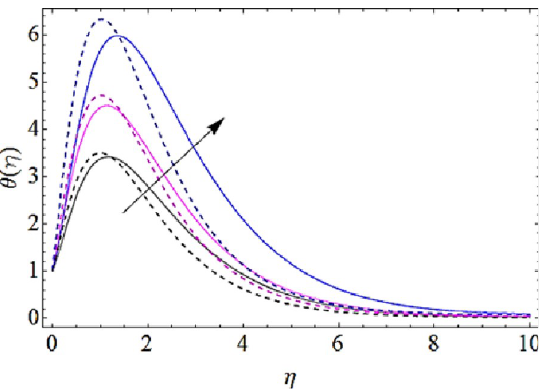
Fig 8. Thermal characteristics for different values of Ag volume